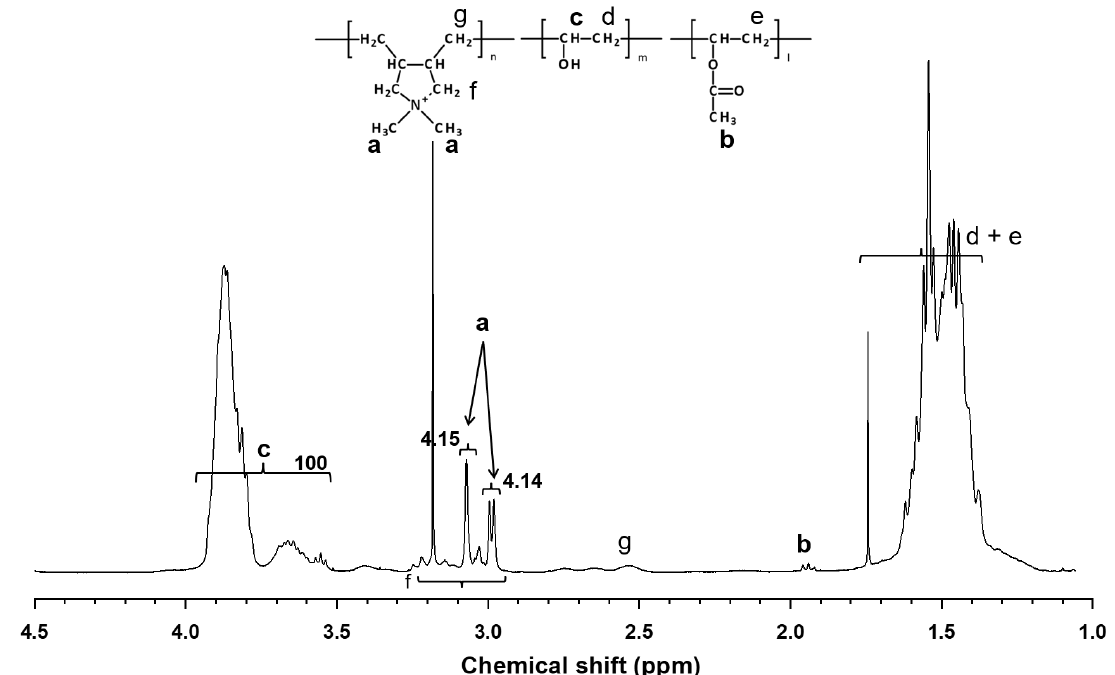
Figure 5. 1 H-NMR spectrum of poly(vinyl alcohol- co -diallyldimethylammonium chloride) (CPVA). The degree of cationiza- tion (DC) and the degree of saponification (DS) were 1.36 mol% and 99.85%,